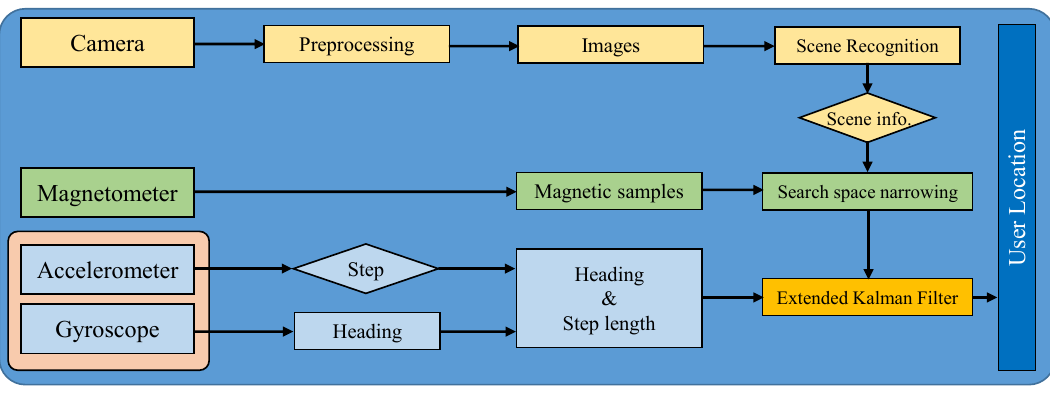
Figure 5. The process followed in location